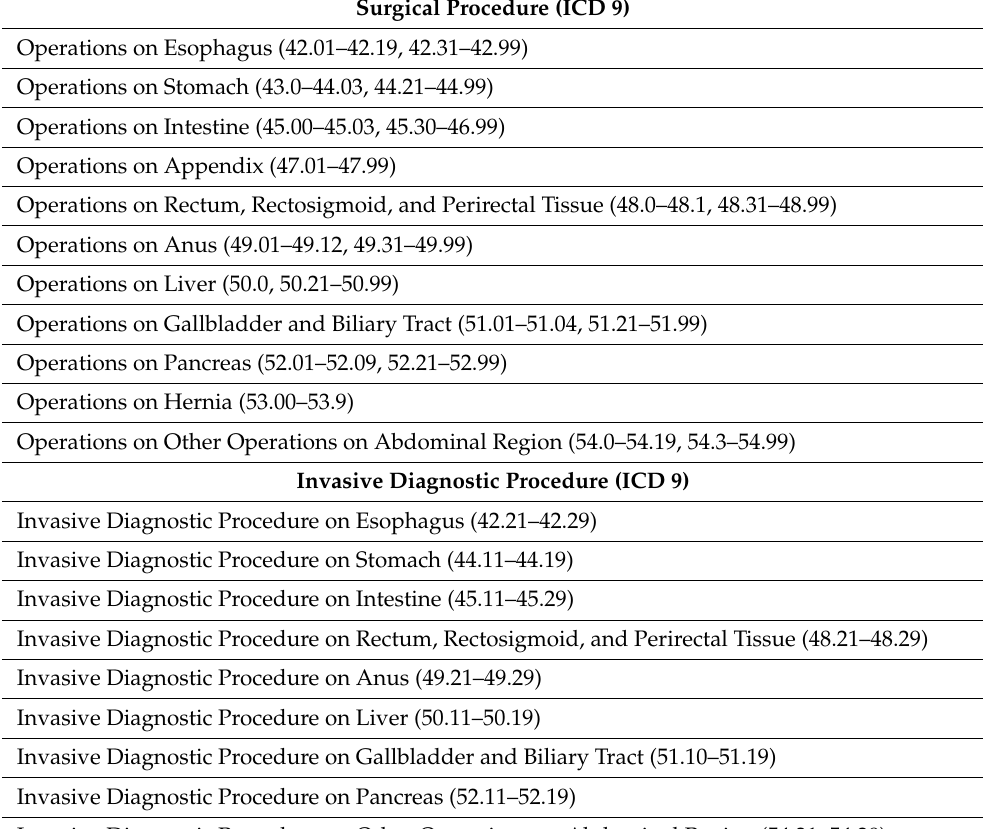
Table 1. Procedures of emergently admitted patients with the primary diagnosis of umbilical hernia. Surgical Procedure (ICD